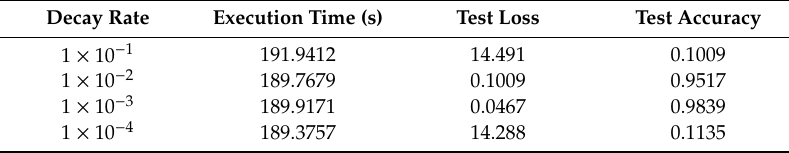
Table 10. E ff ect of learning rate decay on CNN.